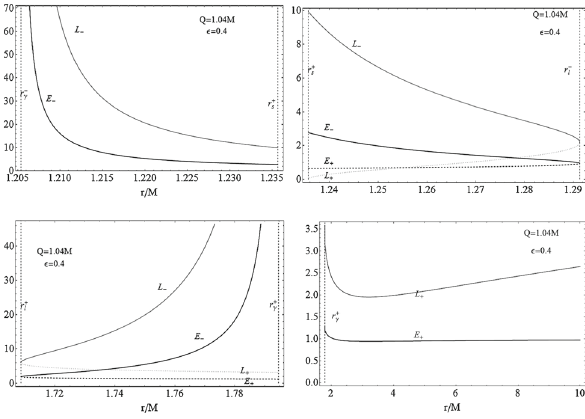
√ √ Fig. 14 Class : 5 /( 2 6 ) M < Q < ( 3 6 / 7 ) M and (cid:9)(cid:9) (cid:2) − < (cid:2) < (cid:2) l . Parameter choice is as follows: Q = 1 . 04 M and (cid:2) = 0 . 4. Then (cid:9)(cid:9) (cid:2) − = 0 . 338294, (cid:2) l = 0 . 566574, r + s = 1 . 23565 M , r − γ = 1 . 20538 M , r + γ = = 1 . 29135 M , and r + = 1 . 70865 M . Circular orbits 1 . 79462 M , r − l l exist with angular momentum L = L + ( gray curve ) and energy E = E + ( black curve ) in r − γ < r < r + s ( upper left plot ); L = 0 at r = r + s ; ≤ r < r + L = L ± in r + s < r < r − ( upper right plot ) and r + γ ( bottom l l left plot ); L = L − in r ≥ r + γ ( bottom right plot